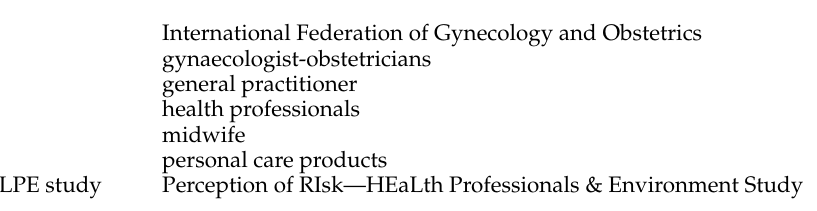
Table S1: Enquiries to perinatal HPs by pregnant women about environmental issues, Table S2: Ability of perinatal HPs to provide appropriate answers to enquires of pregnant women, Table S3. Advice given to pregnant women by perinatal